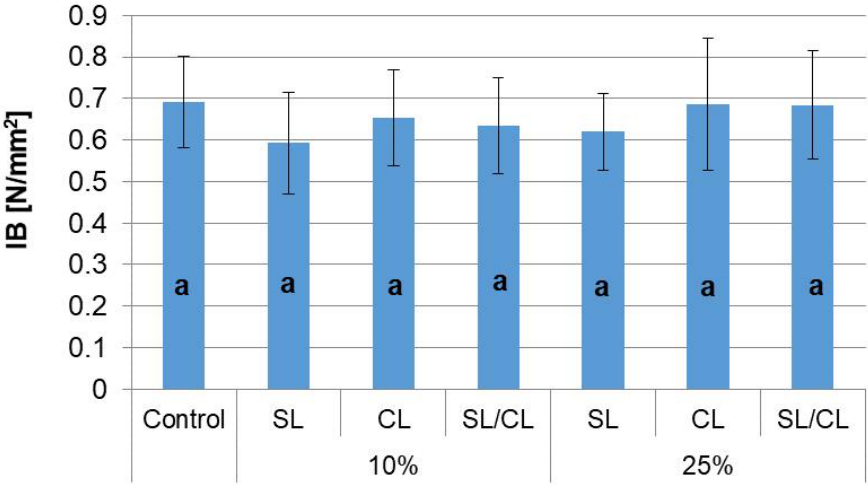
Figure 6. Internal bond of particleboards. a — homogenous group by Tukey test.